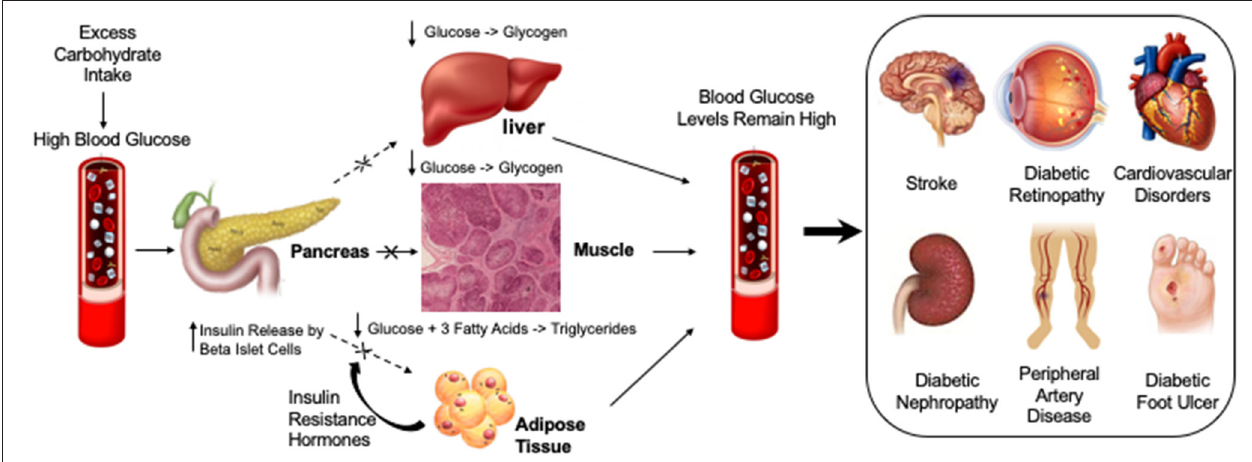
FIGURE 2 | Diabetic compilations are caused by insulin resistance leading to persistently elevated glucose levels or hyperglycemia. Different factors that may cause or exacerbate blood glucose levels are highlighted under “Lifestyle.” High levels of blood glucose in diabetic vessels can cause different diabetic complications such as Diabetic Foot Ulcer, Diabetic Nephropathy, Cardiovascular Disorders, Diabetic Retinopathy, Peripheral artery disease and